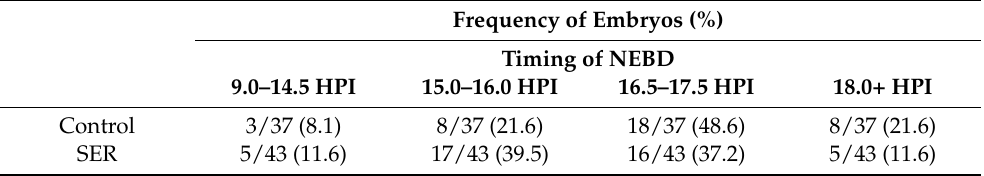
Table 1. Timing of nuclear envelope breakdown (NEBD) using time-lapse microscopy. Time-lapse analysis of control- and SER-generated embryos was performed and the timing of NEBD was categorized into four categories: fast (9.0–14.5 HPI), medium type I (15.0–16.0 HPI), medium type II (16.5–17.5 HPI) and slow (18.0+ HPI). Quantification of individual embryo numbers within each category. N = 4 independent